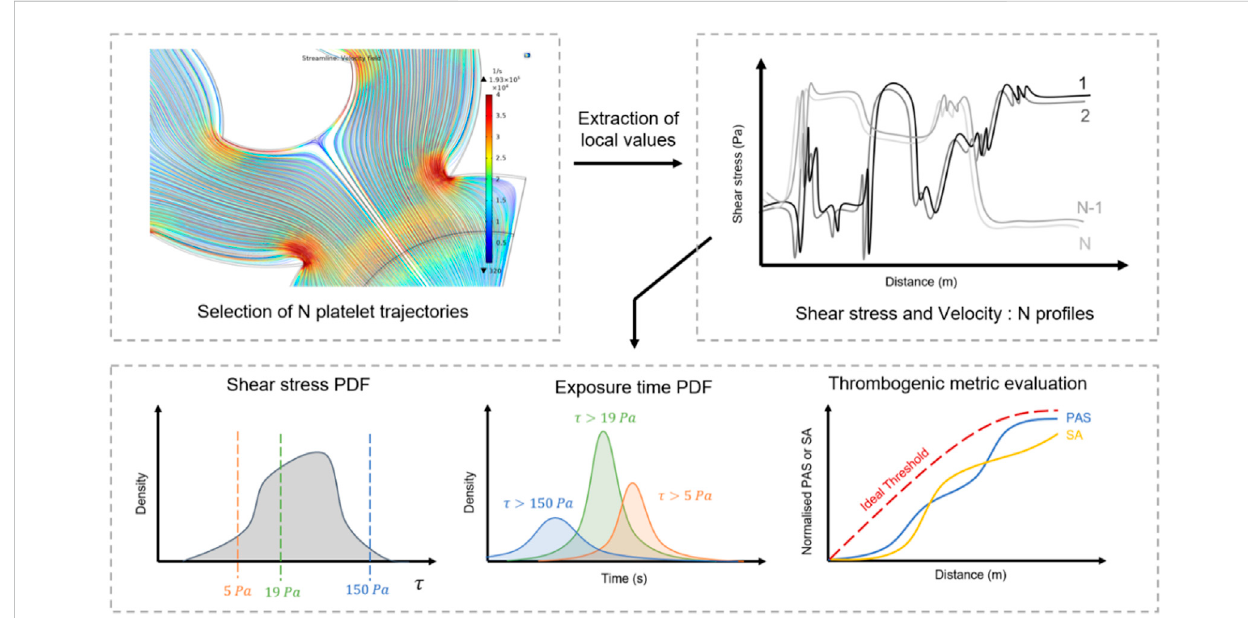
FIGURE 6 Optimisation fl ow chart from CFD analysis of device thrombogenicity. Computational fl uid dynamics provide local mechanical history of a large population of fl owing platelets. The statistical analysis of their mechanical experience: shear stress, time of exposure, thrombogenic metrics enable to draw a global picture of the risks of clotting related to the design.